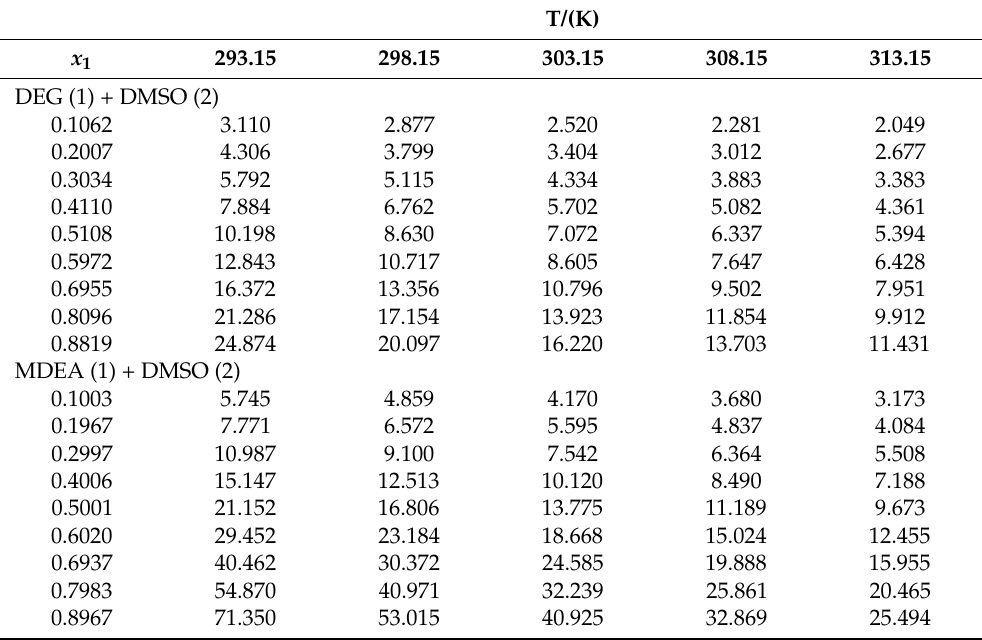
Table 4. Viscosity values η /(mPa · s) as a functions of mole fraction in the temperature range from 293.15 to 313.15 K and at atmospheric